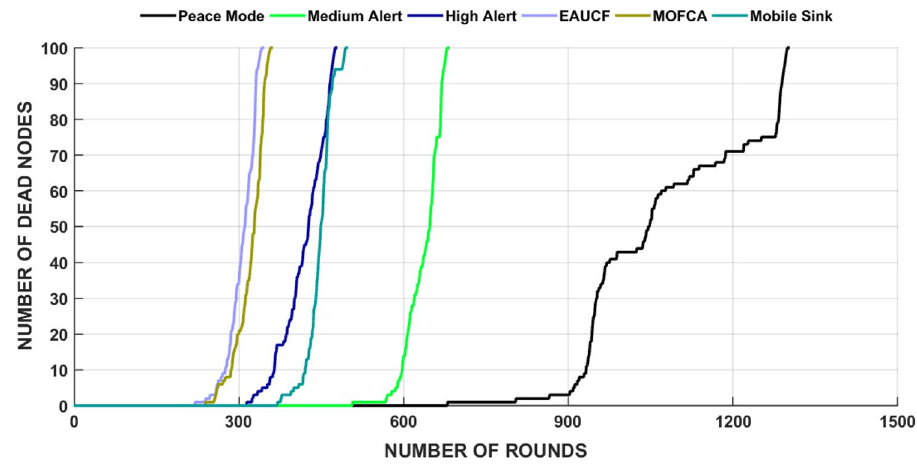
Fig. 13 Ratio of the number of dead nodes to the number of rounds in scenario 3